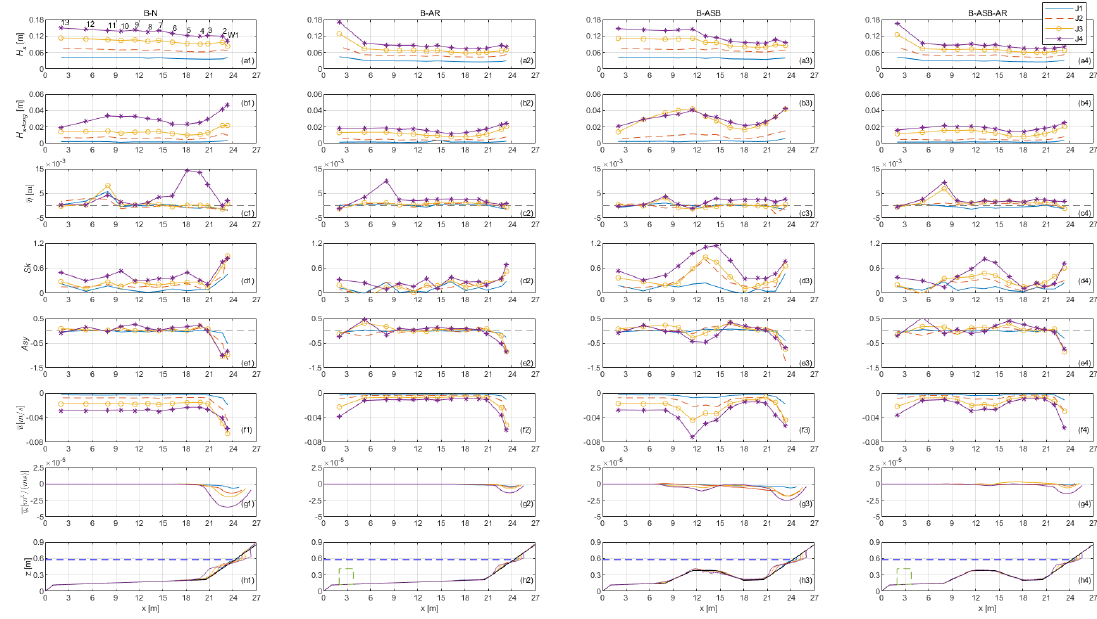
Figure 4. Cross-shore distribution of hydrodynamic and sediment transport parameters ( a1 – h4